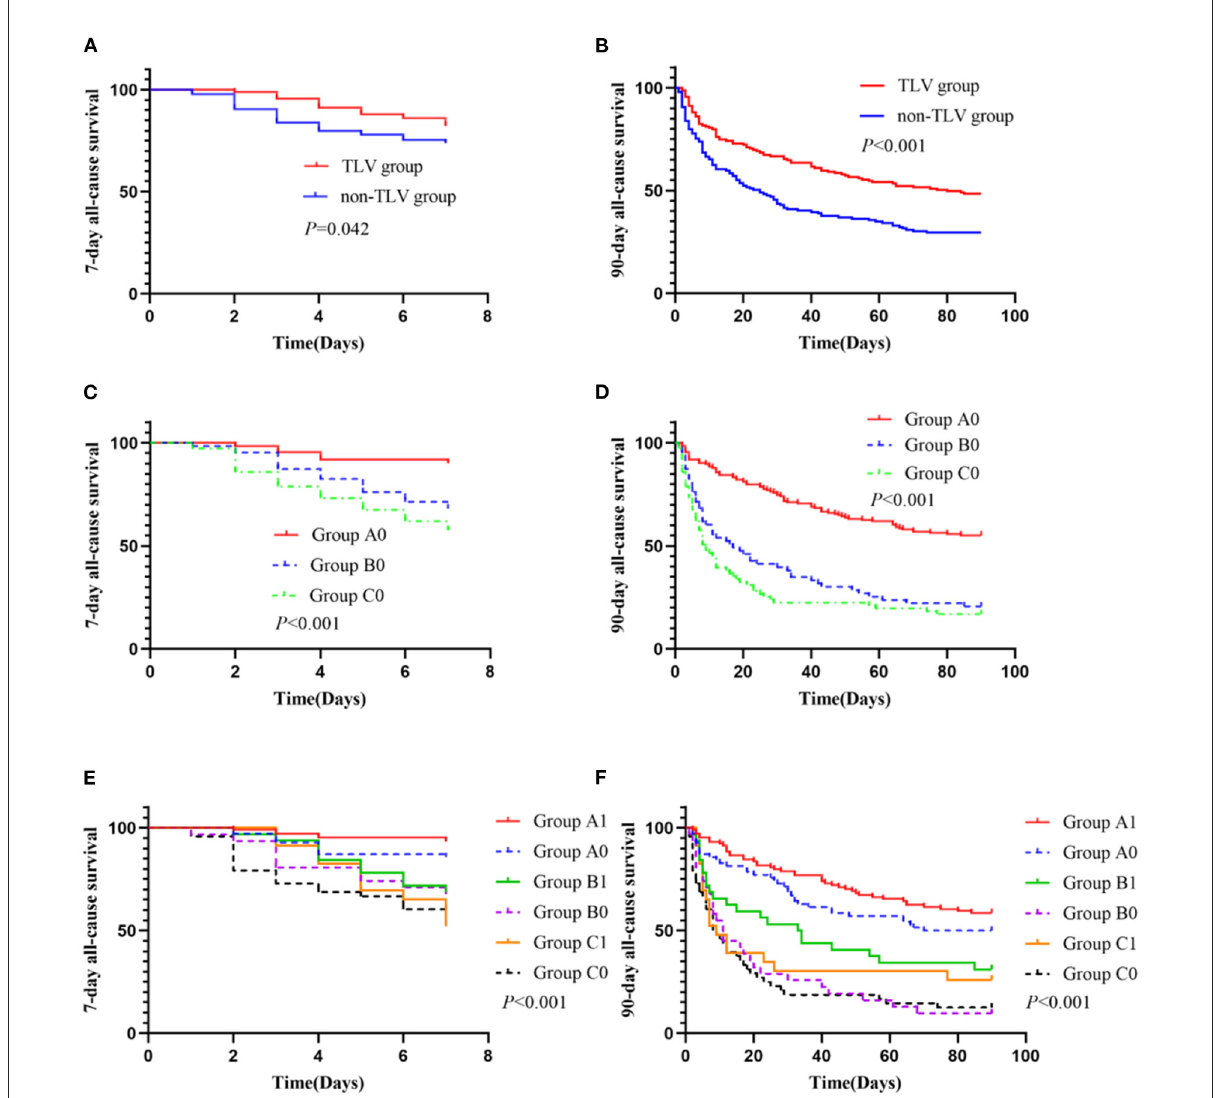
FIGURE4 The primary outcome and subgroup analysis. Group A1 ( n = 104): < 100 mg/d equivalent doses of furosemide plus TLV; Group A0 ( n = 70): < 100 mg/d equivalent doses of furosemide only; Group B1 ( n = 32): ≥ 100 and < 200 mg/d equivalent doses of furosemide plus TLV; Group B0 ( n = 31): ≥ 100 and < 200 mg/d equivalent doses of furosemide only; Group C1 ( n = 23): ≥ 200 mg/d equivalent doses of furosemide plus TLV; Group C0 ( n = 48): ≥ 200 mg/d equivalent doses of furosemide only. (C) Subgroup comparison: Group A0 vs. Group B0, p < 0.001; Group A0 vs. Group C0, p < 0.001; Group B0 vs. Group C0, p = 0.179. (D) Subgroup comparison: Group A0 vs. Group B0, p < 0.001; Group A0 vs. Group C0, p < 0.001; Group B0 vs. Group C0, p = 0.190. (E) Subgroup comparison: Group A0 vs. Group A1, p = 0.096; Group B0 vs. Group B1, p = 0.037; Group C0 vs. Group C1, p = 0.848; Group A1 vs. Group B1, p = 0.057; Group A1 vs. Group C1, p < 0.001; Group B1 vs. Group C1, p = 0.264; (F) Subgroup comparison: Group A0 vs. Group A1, p = 0.180; Group B0 vs. Group B1, p = 0.033; Group C0 vs. Group C1, p = 0.241; Group A1 vs. Group B1, p = 0.001; Group A1 vs. Group C1, p < 0.001; Group B1 vs. Group C1, p = 0.416.